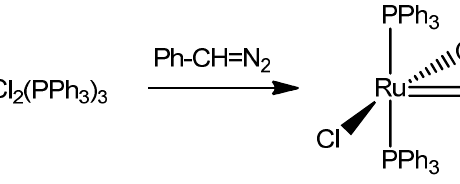
Figure 6. Grubbs catalyst preparation reaction.